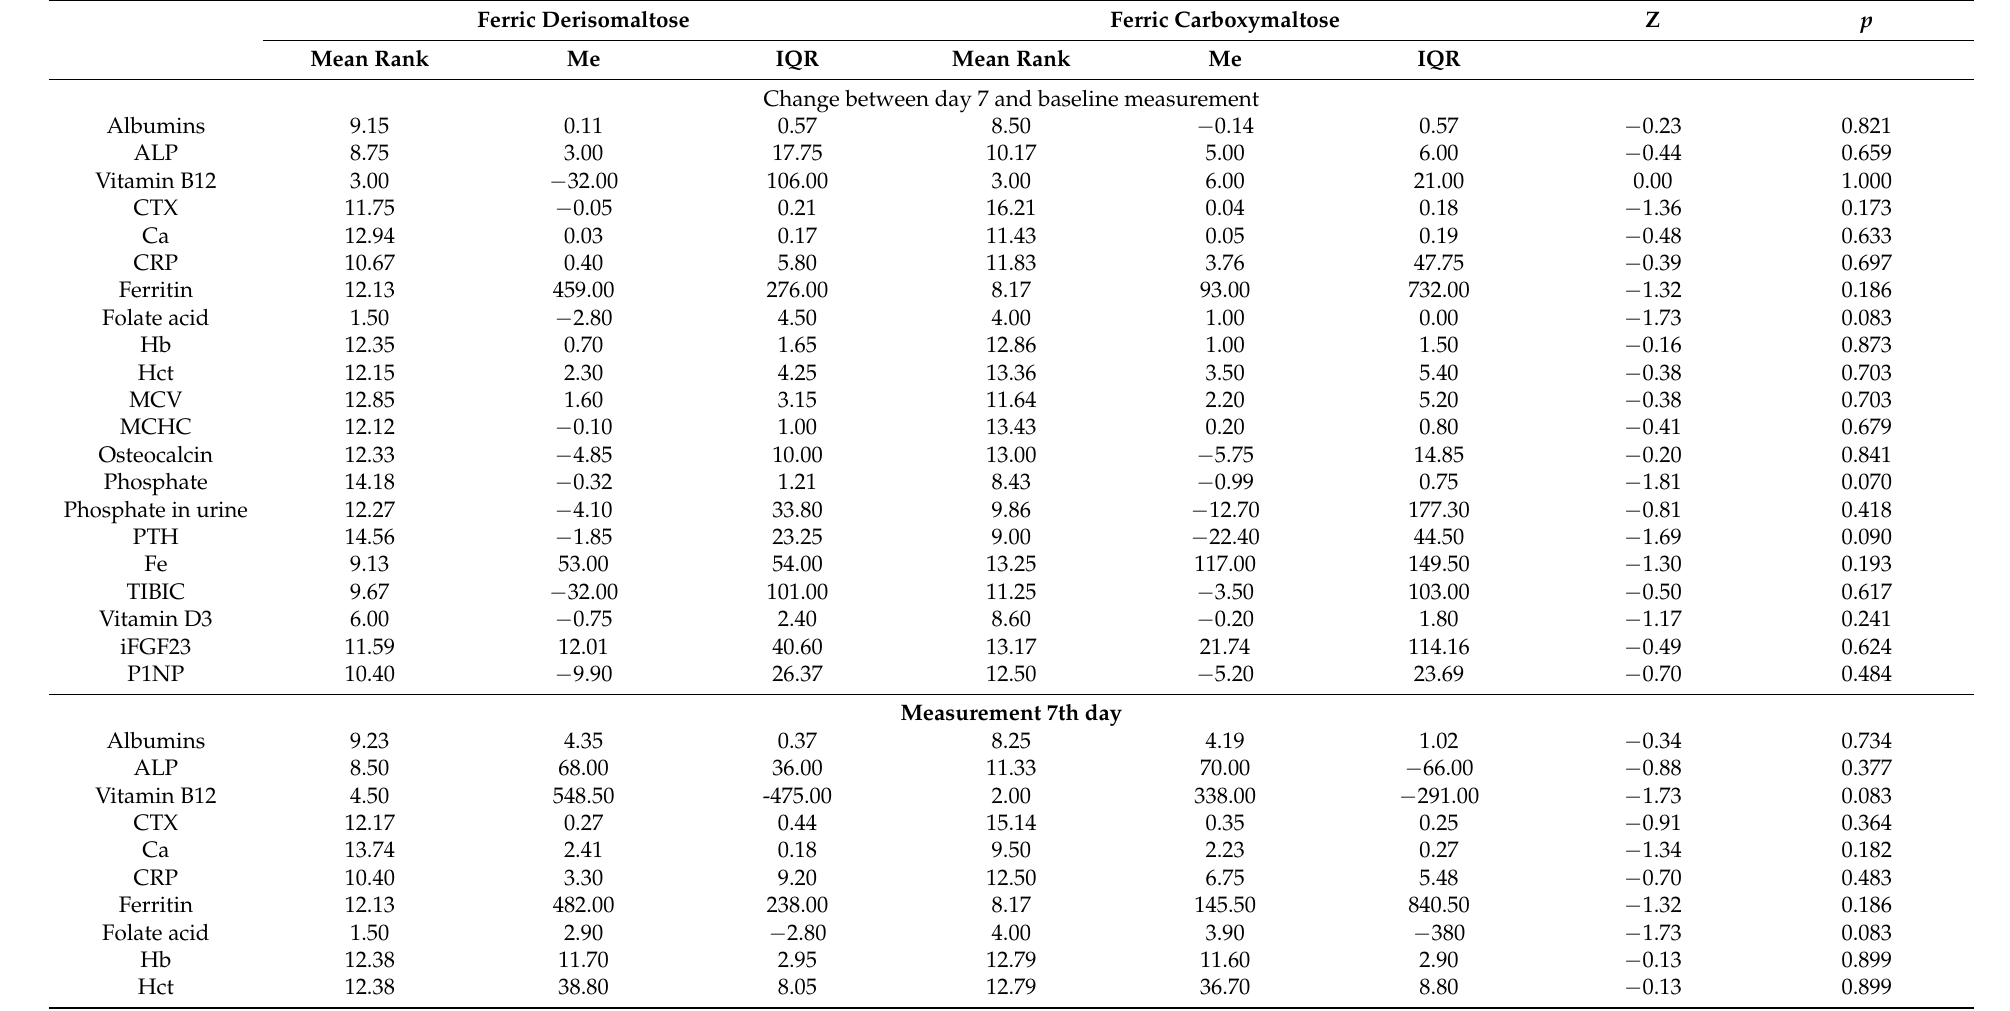
Table 3. Comparison of the biological indicators between patients using ferric derisomaltose and ferric carboxymaltose. Ferric Derisomaltose Ferric Carboxymaltose